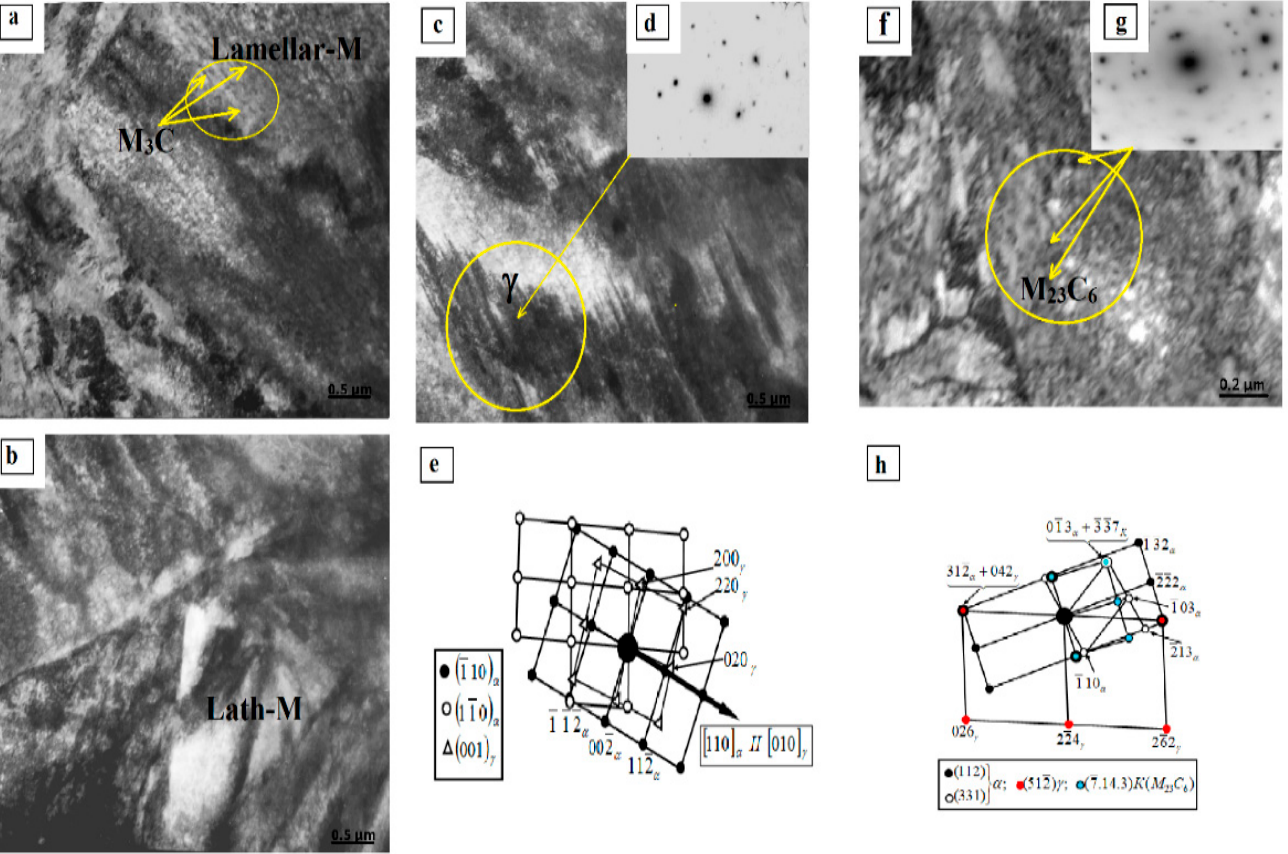
Figure 4. Electron microscopic image of the dislocation structure of the surface of 0.34Cr-1Ni-Mo-Fe steel sample after surface hardening. ( a ) Lamellar martensite, ( b ) Lath (packet) martensite, ( c – e ) γ –Fe residual austenite, its microdiffraction pattern and indexed schema, ( f – h ) M 23 C 6 are carbides in the form of a colony, its microdiffraction pattern and indexed schema.